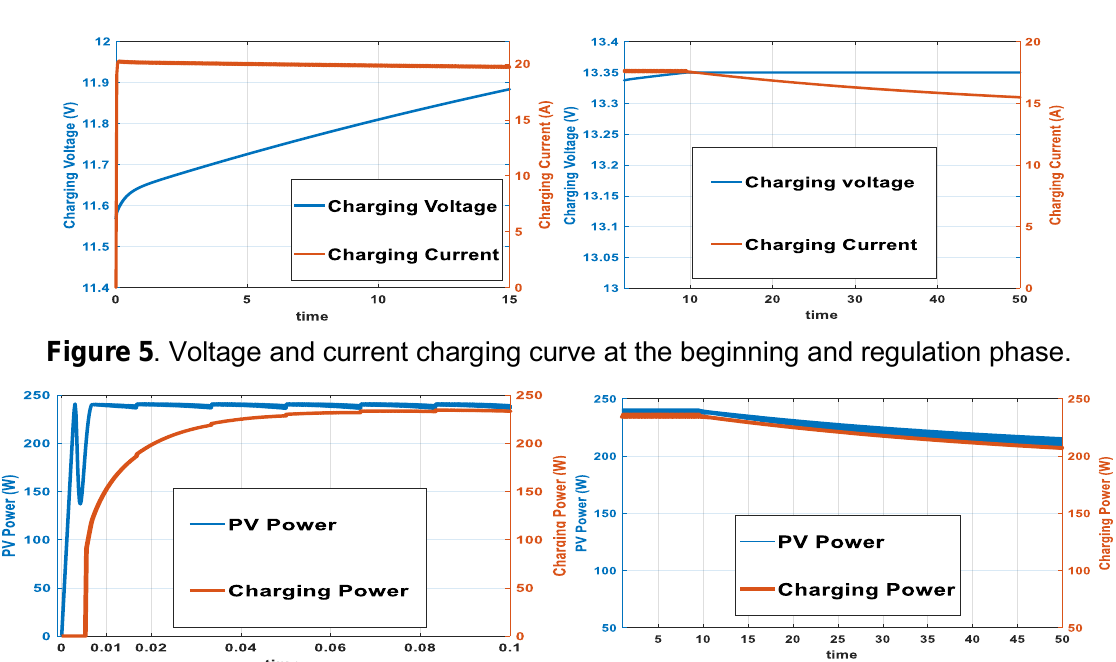
Figure 6 . PV Power and charging Power at the beginning and regulation